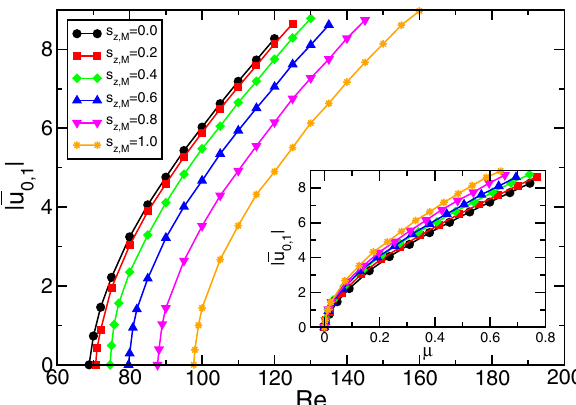
Figure 3. Mode amplitudes | u 0,1 | of (dominant) radial flow field amplitudes of TVF at mid gap versus Reynolds number Re . The inset shows the same but using the relative distance µ = Re ( s z , S )/ Re 0 c − 1 , of the Reynolds number Re from the respective onset with different modulation amplitudes s z , M in the magnetic fields as